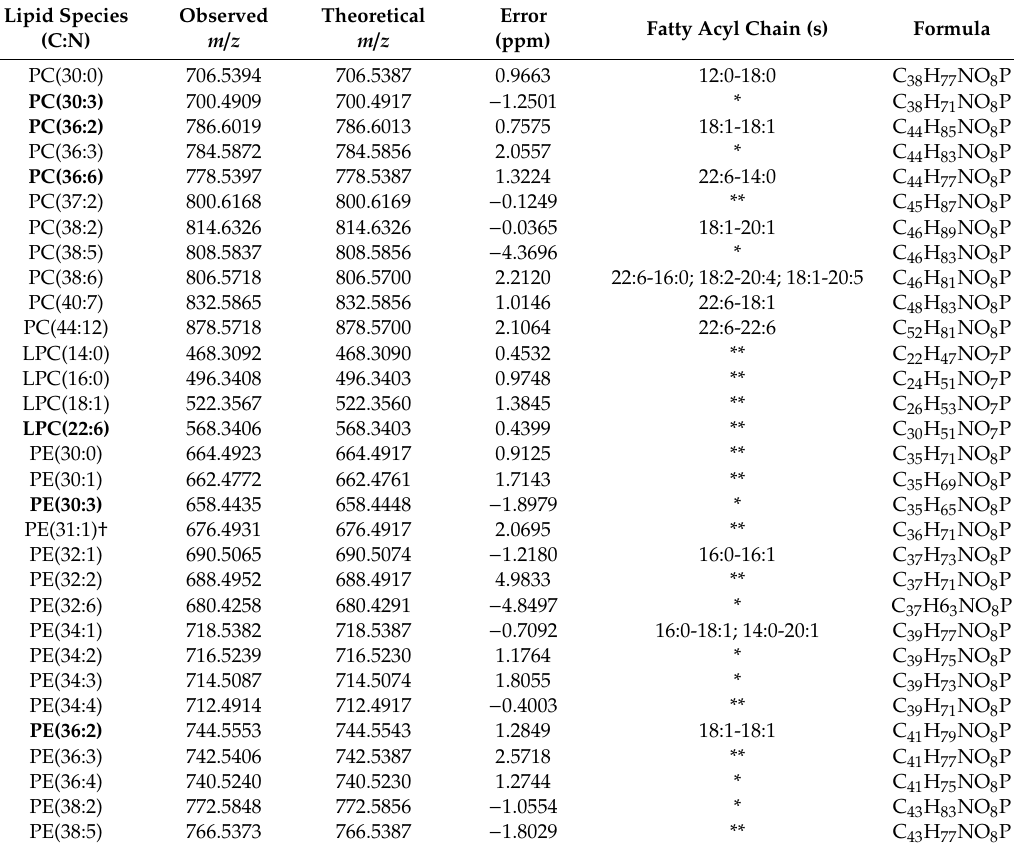
Table 5. Phospholipid species identified by liquid chromatography–mass spectrometry (LC–MS) in positive mode as [M + H] + ions. Polar head groups were confirmed by tandem MS (LC–MS /